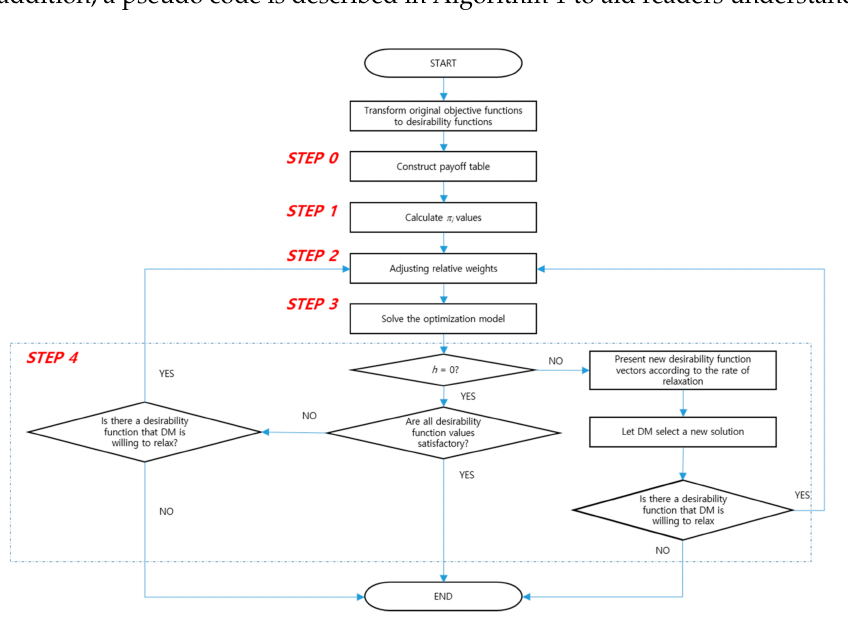
Figure 1. The overall procedure of the proposed